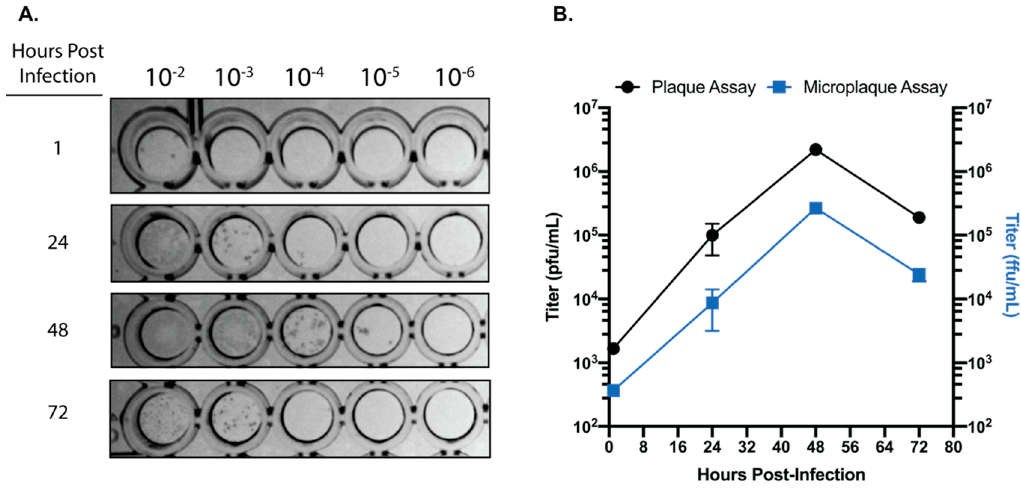
Figure 3. SARS-CoV-2 focus forming assay. ( A ) Representative image of the foci observed from serially diluted supernatants from infected Calu-3 cells. ( B ) Comparison of titers obtained from traditional plaque assay and focus forming assays on matched supernatants collected from SARS-CoV-2 infected Calu-3 cells. Data are representative of the mean and SEM of 3 replicates.